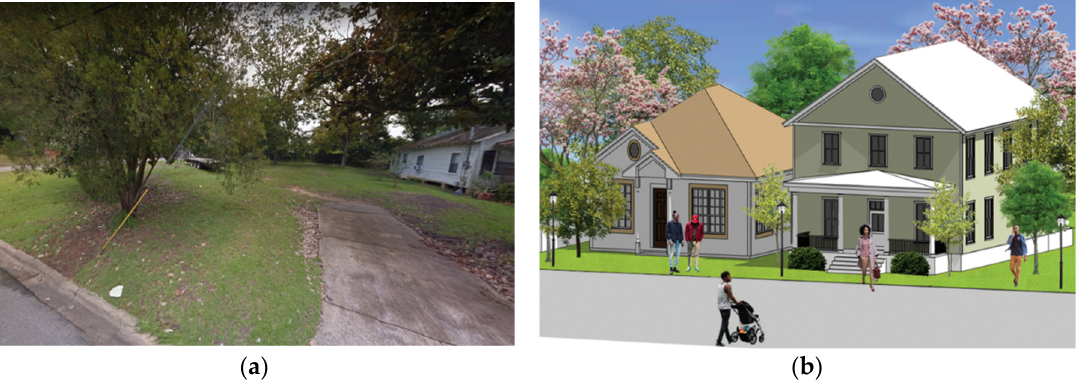
Figure 10. Affordable housing: before (a); and after (b).